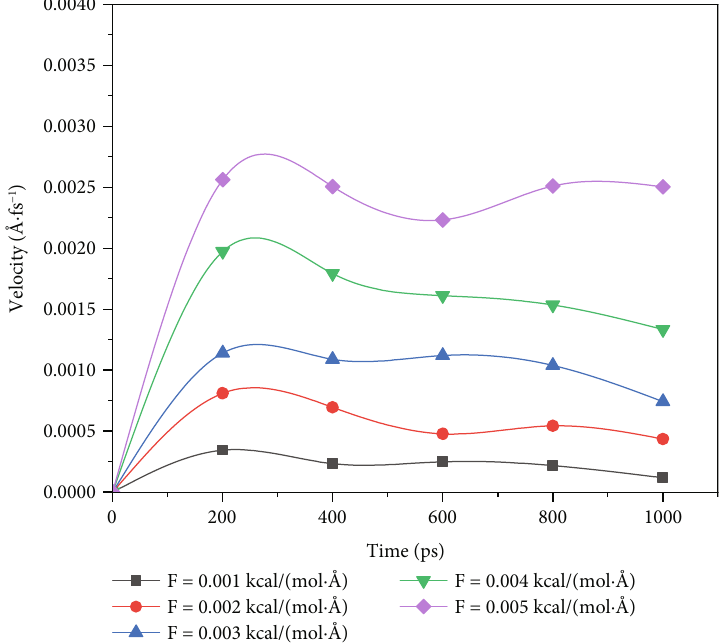
Figure 11: Variation trend of the COM velocity of the oil with time under di ff erent driving forces.